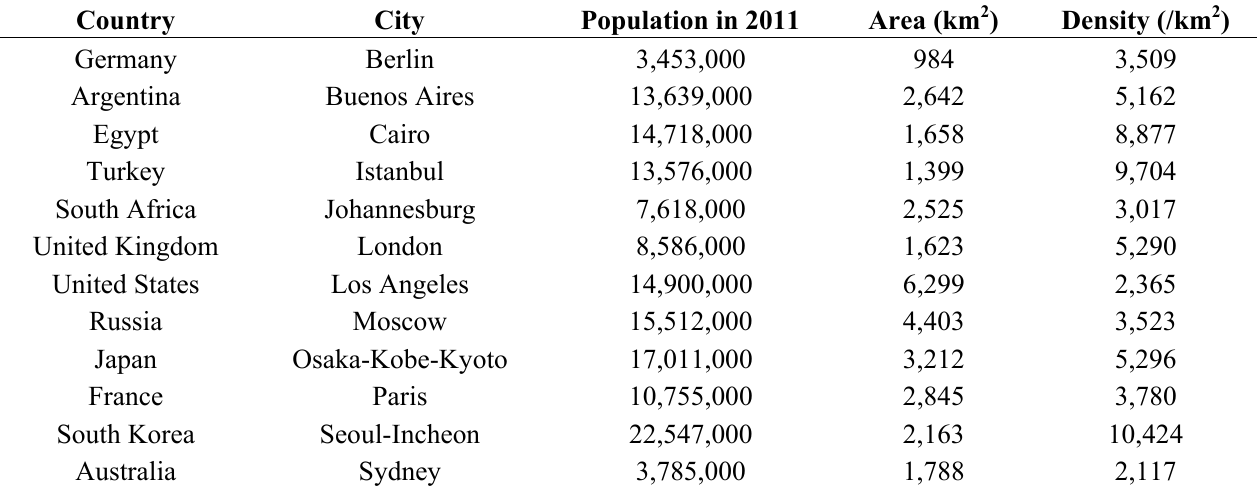
Table 1. Selected urban areas. Source: Demographia